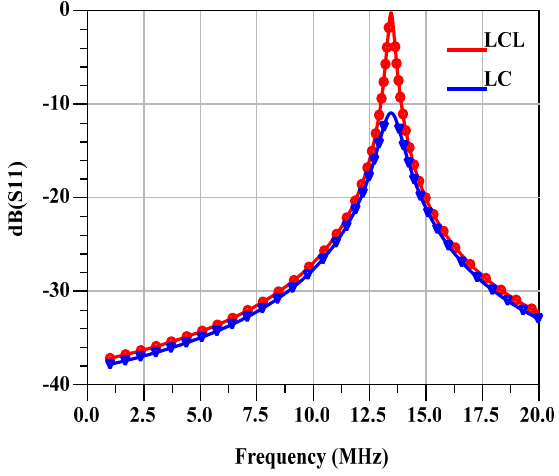
Figure 12. Frequency response of PA with matching.